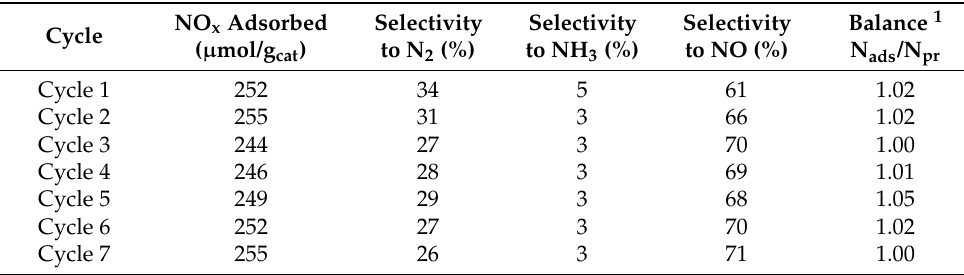
Table 1. Data from NO x storage/H 2 reduction consecutive pulses (and final TPD), conducted at 300 ◦ C for Ba6/Cu2CZ.